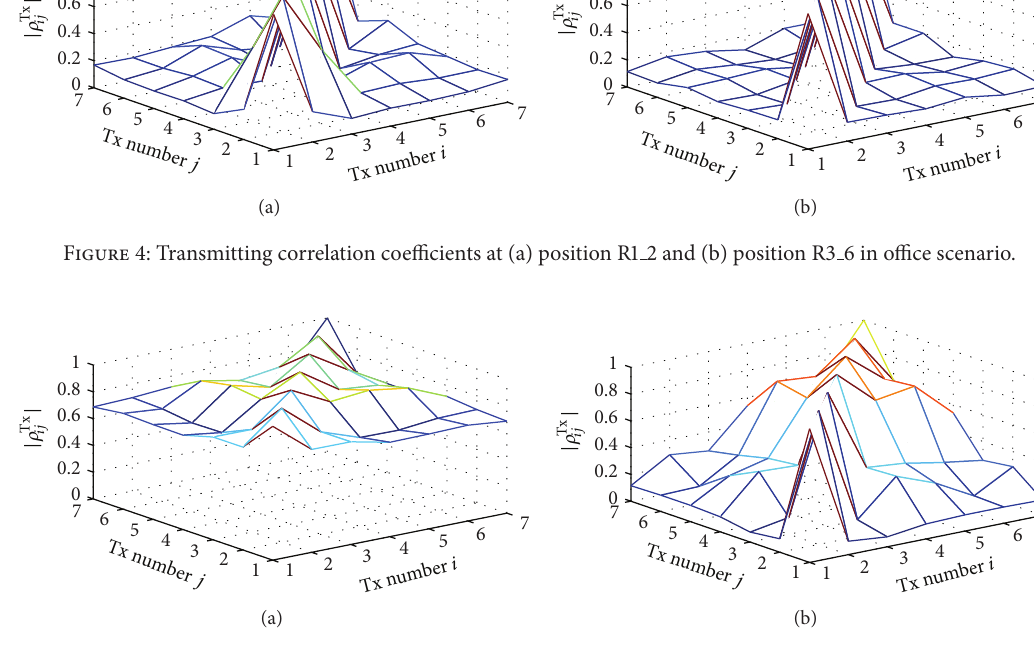
Figure 5: Transmitting spatial correlation coefficients at (a) position P1 and (b) position P2 in corridor scenario.